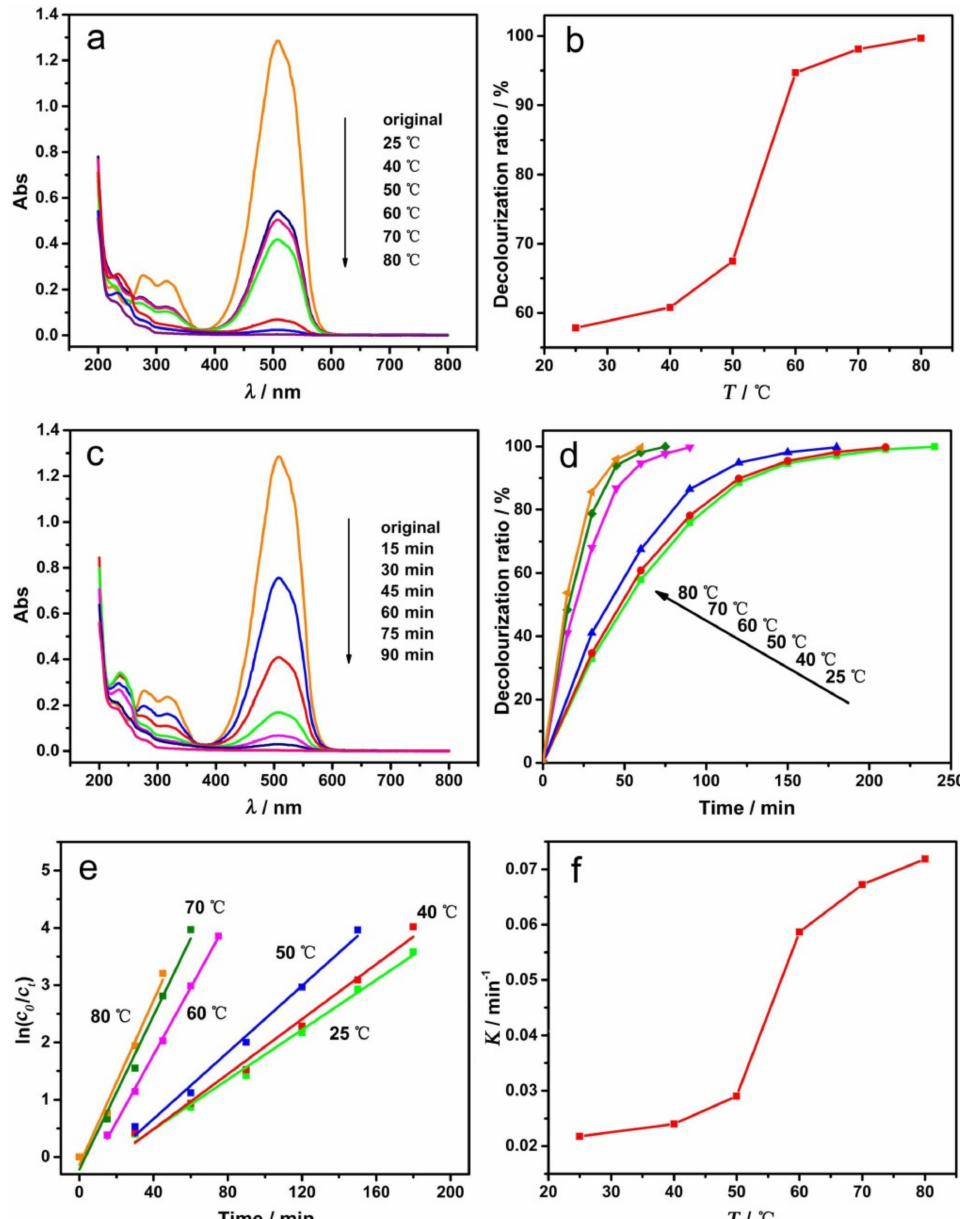
Figure 7. Effect of degradation temperatures with GCF-0.2 cathode: UV–visible absorption spectra of MO at different temperatures ( a ); the decolorization ratio-temperature curve ( b ); UV–visible absorption spectra of MO at 60 ◦ C for different times ( c ); the curve of decolorization ratio versus time at different temperatures ( d ); plots of ln( c 0 / c t ) versus time ( e ); curve of the rate constant (K) versus temperature ( f